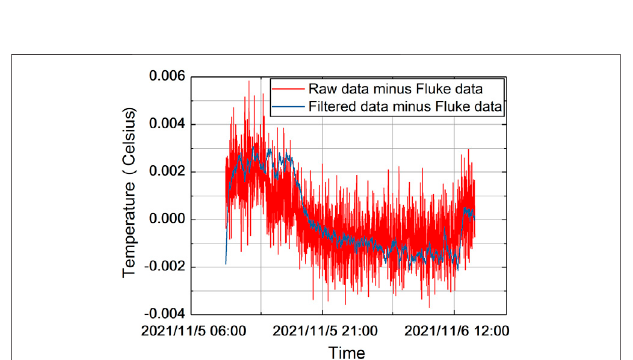
FIGURE 11 | Local zoom of raw data and its fi ltered data compared to Fluke data.